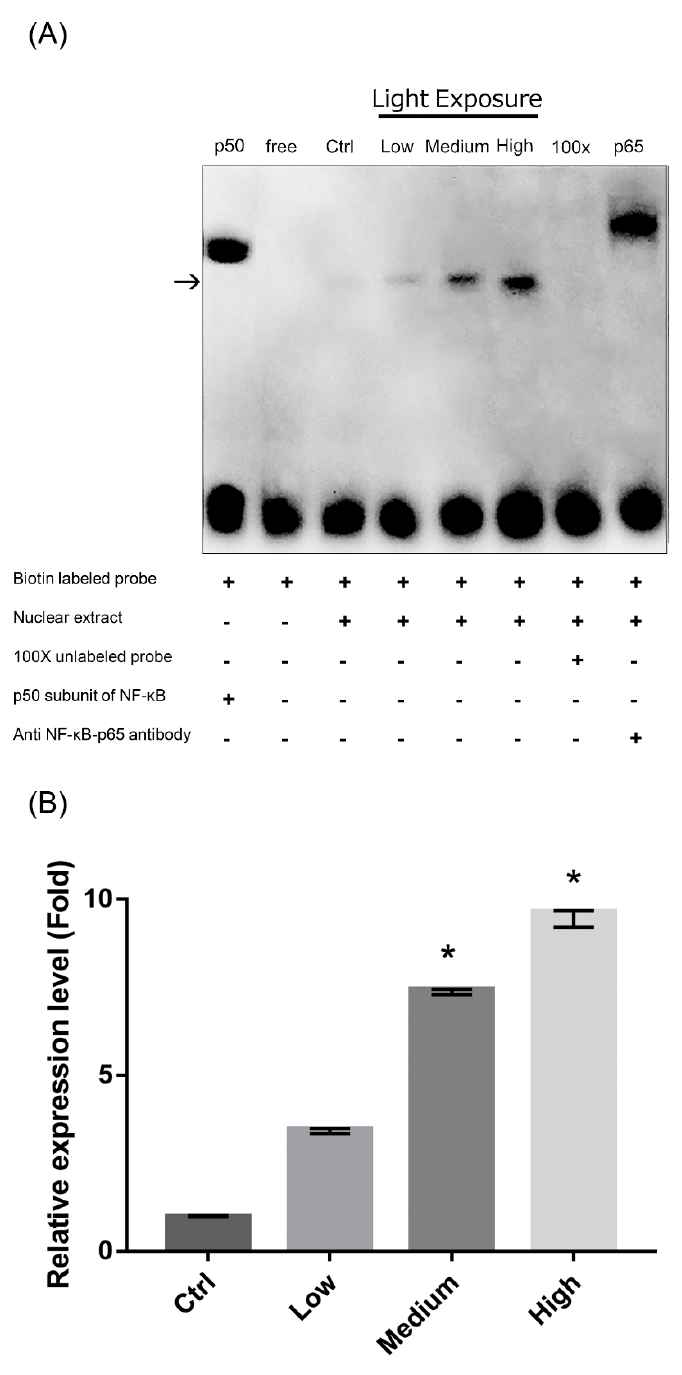
Figure 8. Exposure to liquid crystal display (LCD) with higher ocular energy exposure index (OEEI) activates the nuclear factor- κ B (NF- κ B) pathway. ( A ) Electrophoretic mobility shift assay (EMSA) was used to evaluate the DNA-binding activity of NF- κ B in 661W cells after exposure to LCD with low, medium, and high OEEI for 3 days. Adding a 100-fold molar excess of unlabeled NF- κ B probe completely inhibited the binding of labeled probe to the NF- κ B / DNA complex. Lane 1: p50 subunit of NF- κ B; Lane 2: free probe; Lane 3: control group, no light exposure; Lane 4: Low OEEI group; Lane 5: medium OEEI group; Lane 6: high OEEI group; Lane 7: competition with 100x unlabeled NF- κ B probe; Lane 8: anti-p65 antibody supershift band. ( B ) Quantification of EMSA results. Expression level in the control group was arbitrarily set as 1. Ctrl: control group, no light exposure; All data represent the median and the interquartile range. * p < 0.05 compared to the low OEEI group using Kurskal-Wallis test with post hoc Dunn test; n = 3 in each group.